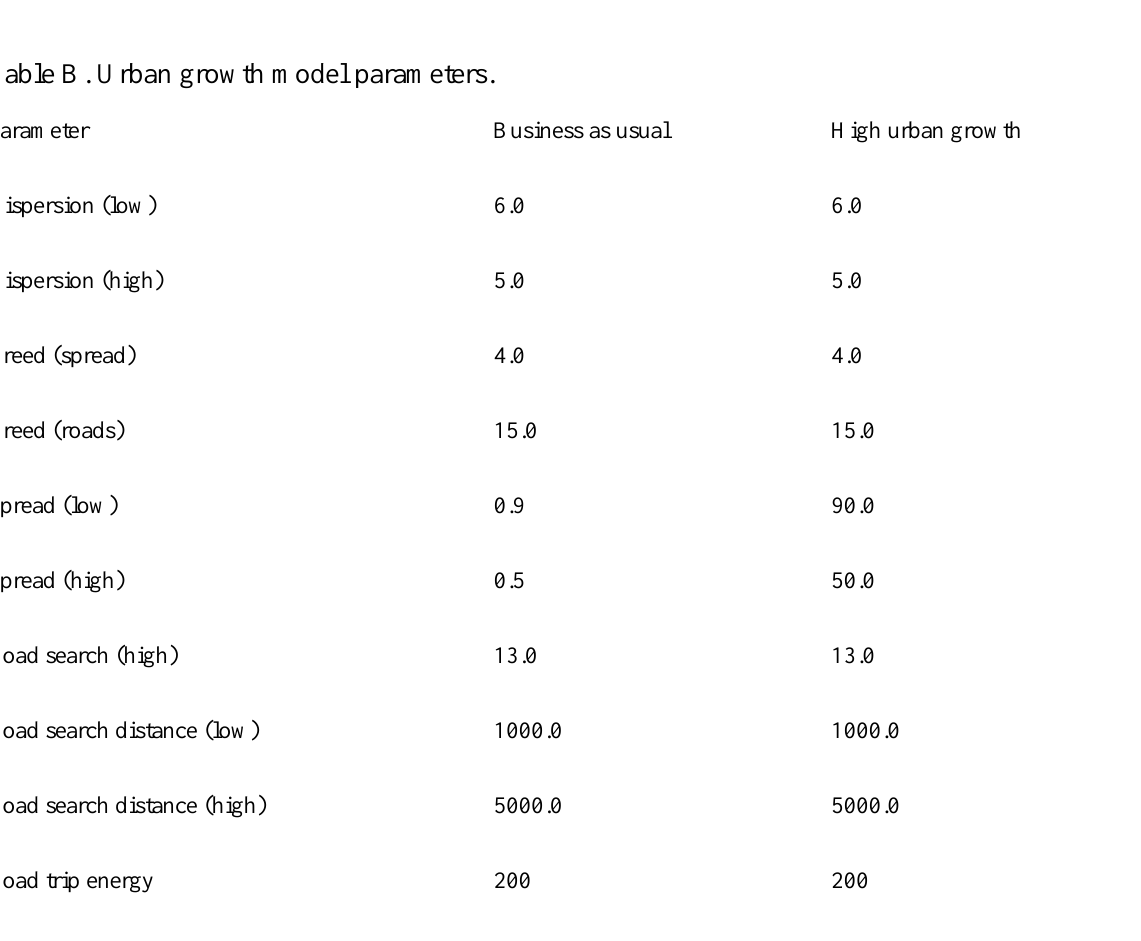
Table C. Land-cover transitions